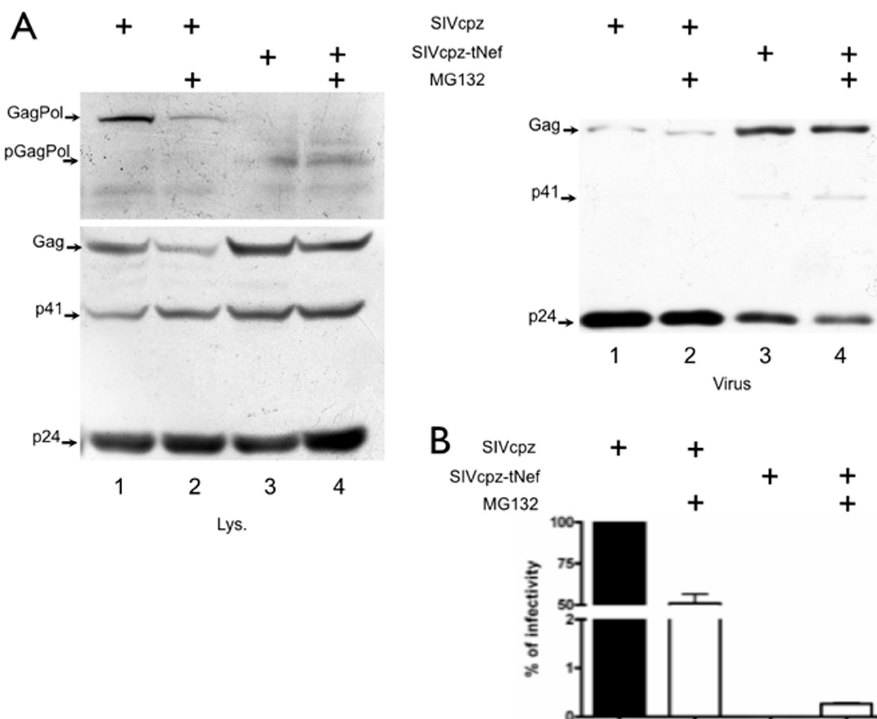
Figure 5. Treatment with proteasome inhibitor does not increase levels of GagPol in SIVcpz-tNef. ( A ) Hek-293T cells were transfected with SIVcpzWT and SIVcpz-tNef clones. After 24 h, the culture medium was replaced, and 5 μ M of the proteasome inhibitor MG132 diluted in DMSO or DMSO alone as control were added. After 5 h, supernatants and lysates were collected. Western blotting with polyclonal α -p24 of cell lysates showing full-length and partially-processed GagPol (pGagPol) (top panel); Gag, p41 and p24 (bottom panel). Western blotting of viral lysates with polyclonal α -p24 showing Gag, p41 and p24 (bottom panel); ( B ) Infectivity assays of non-normalized supernatants are represented as the percentage of the non-treated SIVcpzWT control. Results represent three independent experiments.